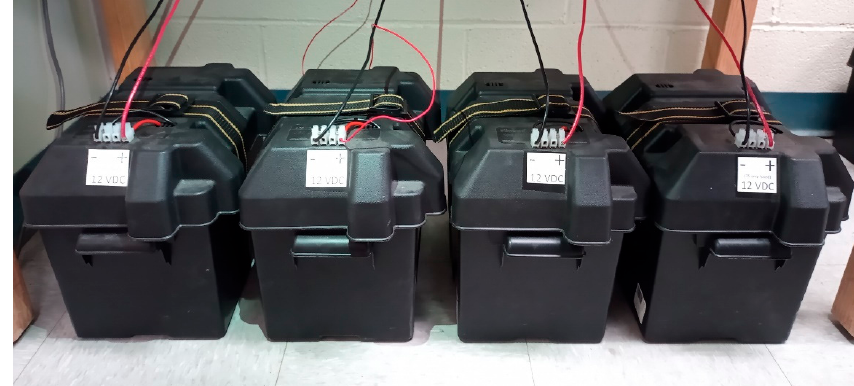
Figure 10. Battery bank.